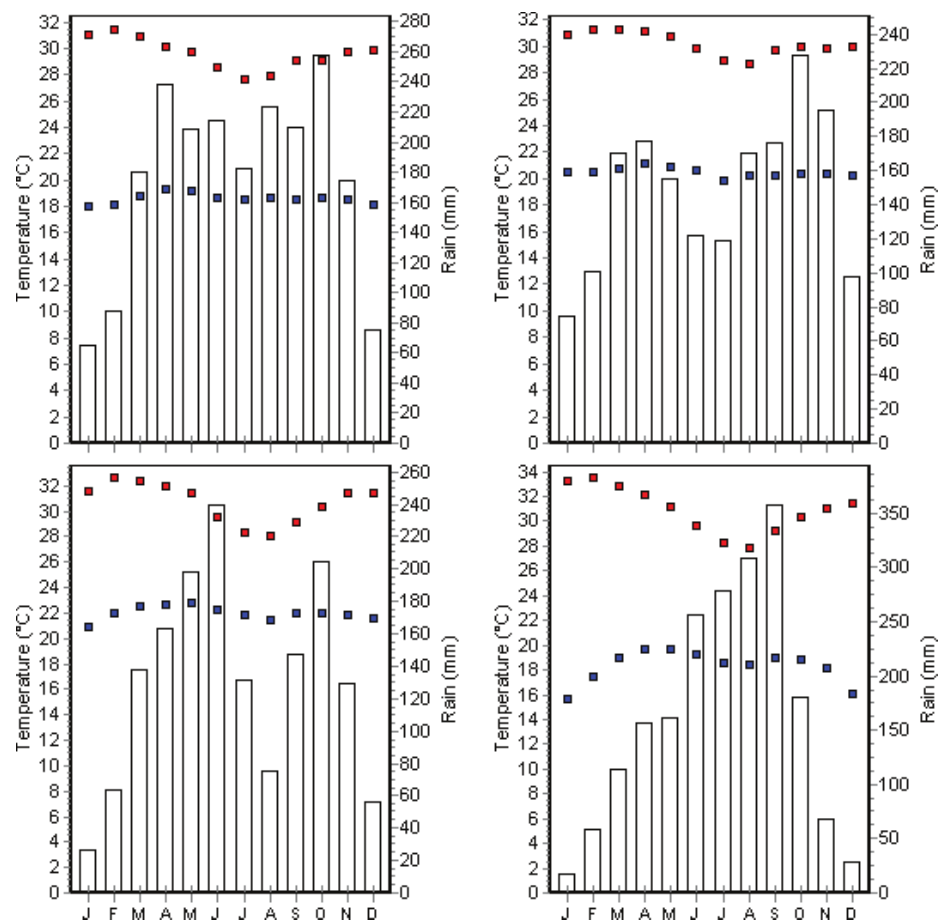
Fig. 8. Climate graphs for Pawa (upper left), Mbiye (upper right), Oda (lower left), and Matonguiné (lower right). Upper line of squares: mean monthly maximum temperature, lower line of squares: mean monthly minimum temperature, bars: mean monthly precipitation (plotted using DIVA-GIS, data from Hijmans et al.